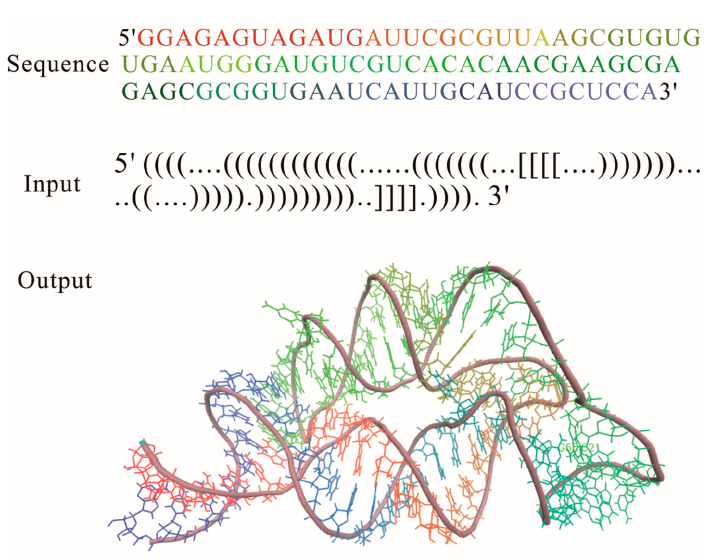
Figure 3. Three-dimensional (3D) structure for THF riboswitch aptamer (PDB code: 3SD3) predicted by using RNAComposer program online.